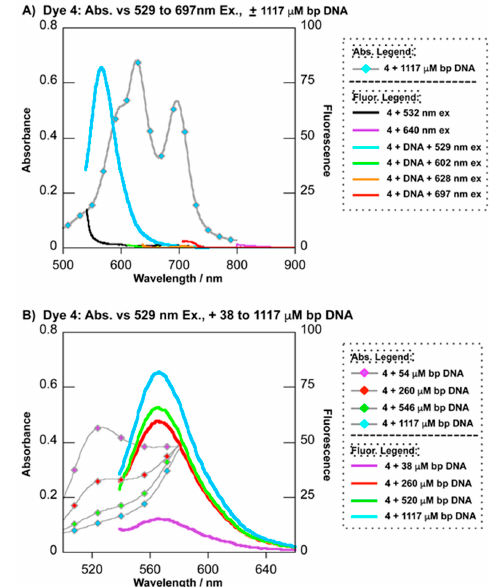
Figure 7. Double y -axis plots superimposing dye 4 fluorescence emission spectra (Em) with dye 4 UV–visible absorption (Abs) (22 ◦ C). Samples contained 10 mM sodium phosphate bu ff er pH 7.0,